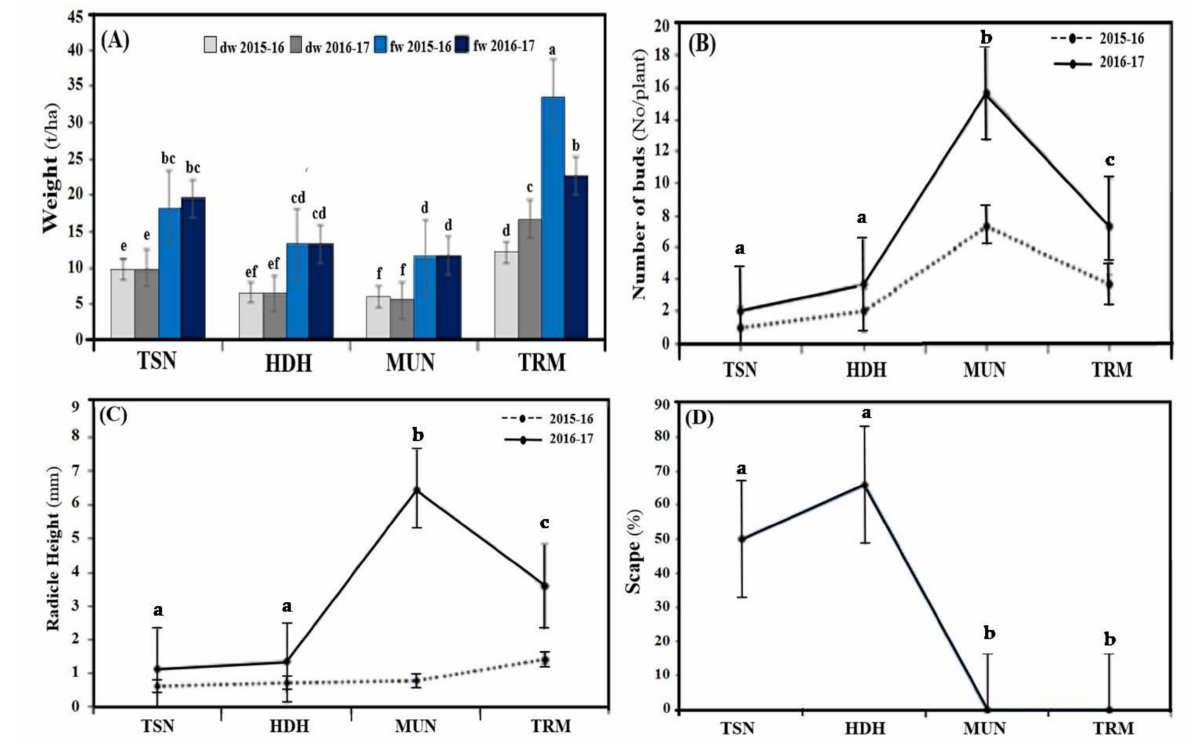
Figure 1. ( A ) Dry weight (dw) and fresh weight (fw), ( B ) number of buds, ( C ) radicle height, and ( D ) scape of A. sativum in different cultivars. Data are shown as mean ± standard deviation, and different letters denote statistically significant differences between experimental groups at the p < 0.05 level, according to Duncan’s multiple range